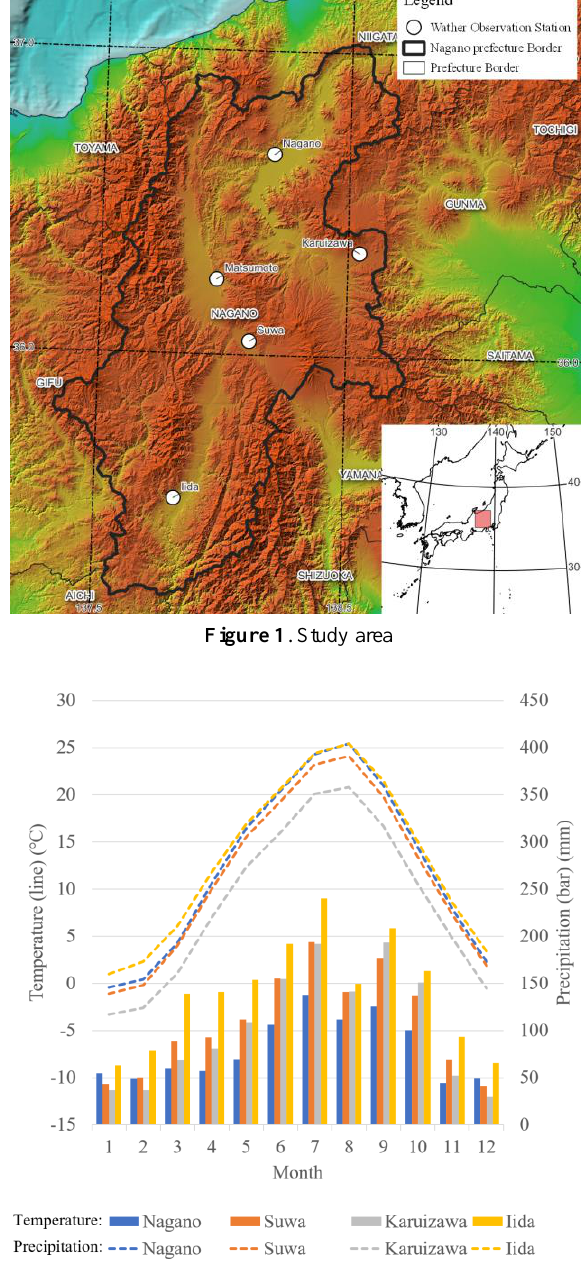
Figure 2 . Weather conditions for Nagano